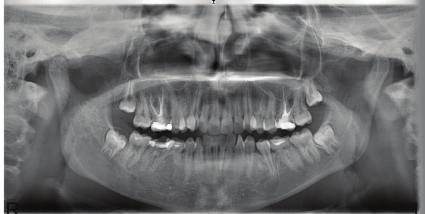
Figure 2: Panoramic radiography shows ground-glass ill-defined lesions in the three different regions of the maxilla and mandible.